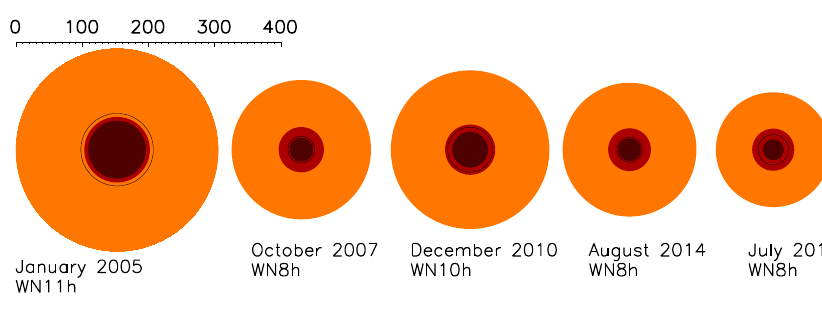
Figure 7. Change of the wind structure and extent over time. The region where n e ≥ 10 12 cm − 3 is shown in dark red, 10 12 ≥ n e ≥ 10 11 cm − 3 in red, and 10 11 ≥ n e ≥ 10 10 cm − 3 in orange. Solid black line shows the radius where Rosseland optical depth ( τ ) is 2/3. Scale in units R (cid:12) is shown at the top.